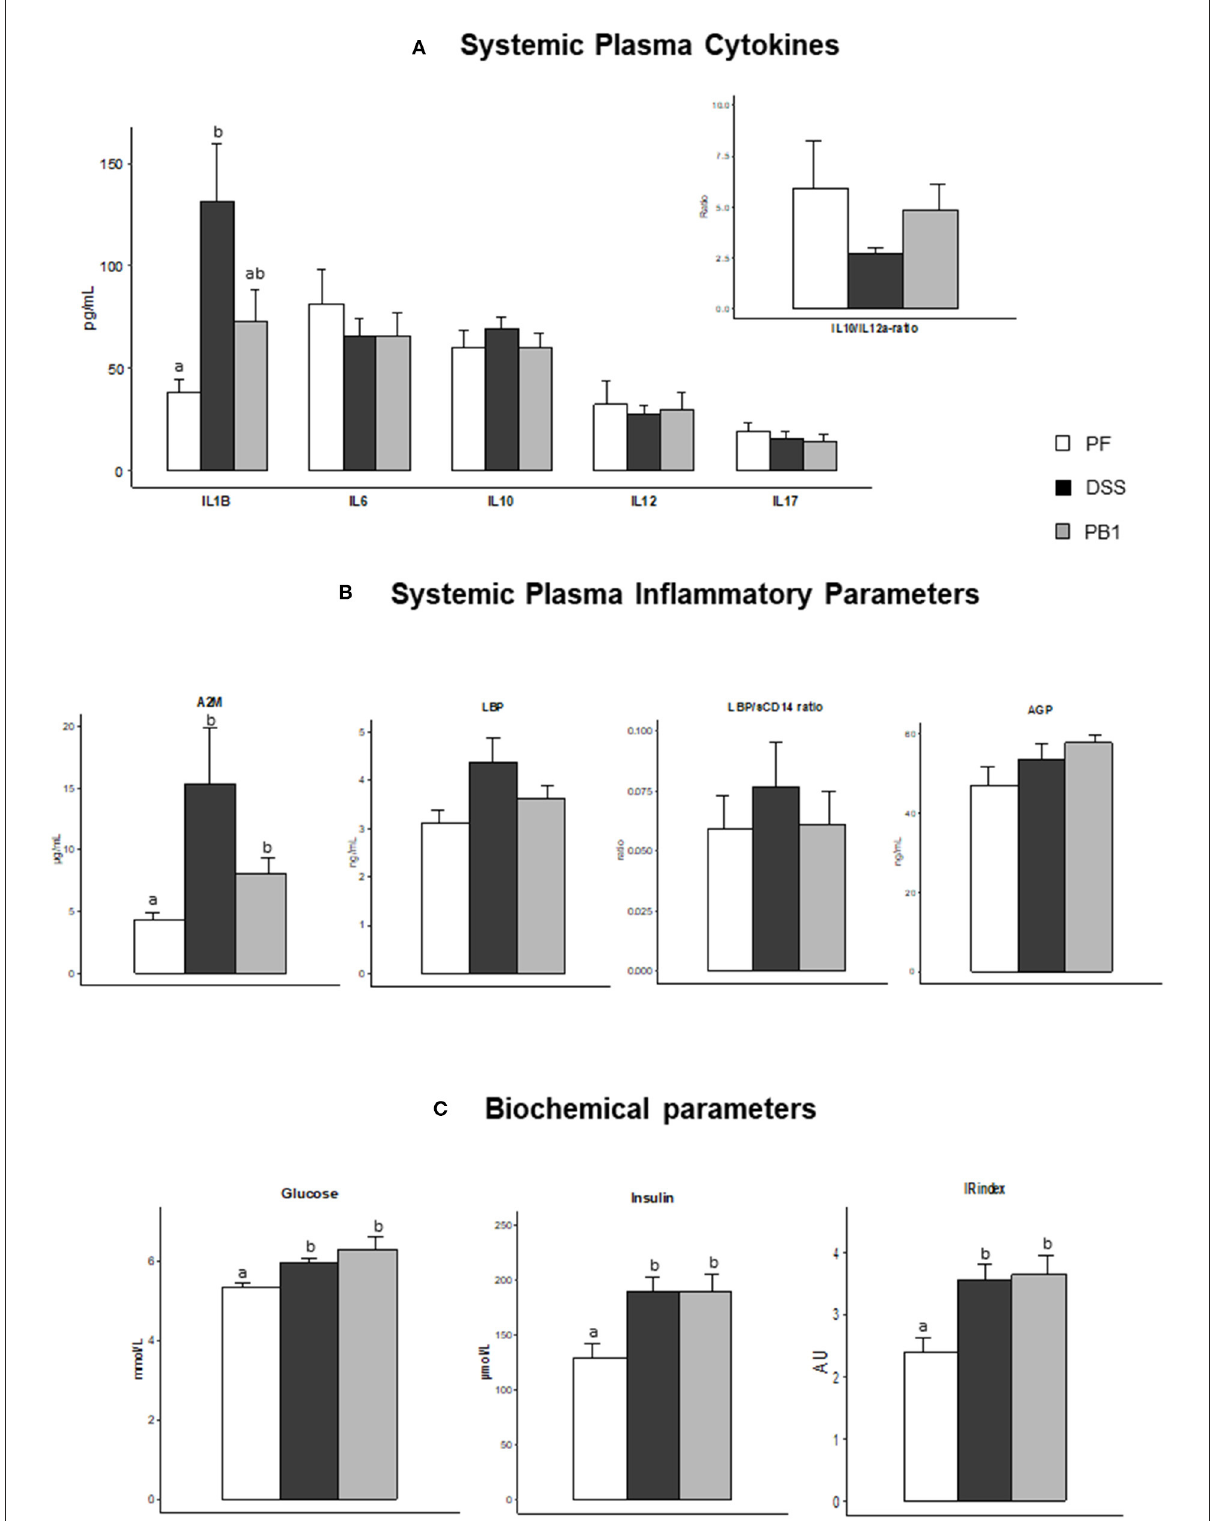
FIGURE4 Impact of Dextran sodium sulfate with (PB1) or without probiotic supplementation (DSS) on insulin sensitivity status and systemic inflammation in adult older rats. (A) Evolution of rats’ plasma cytokines levels: IL1B, IL6, IL10, IL12p70, IL17 and IL10/IL12 ratio, (B) Evolution of rats